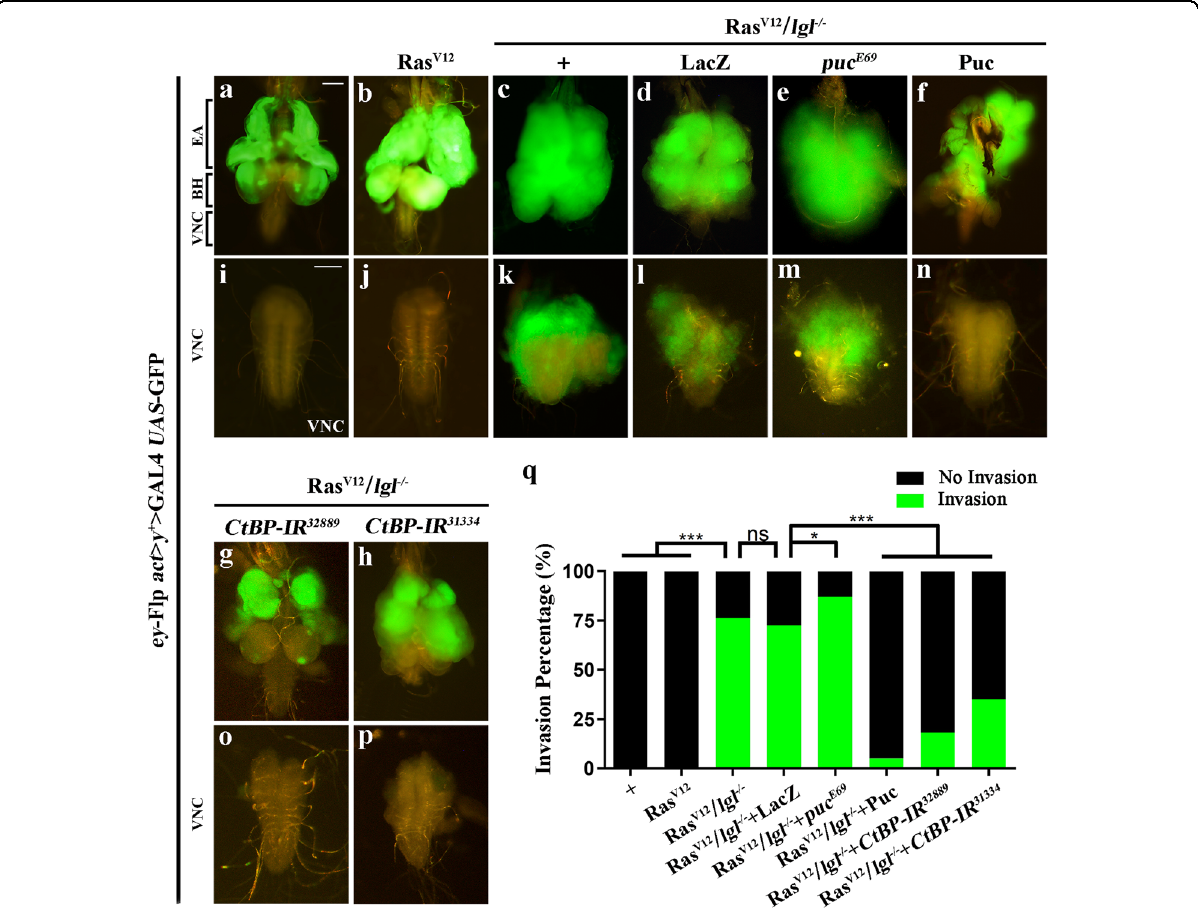
Fig. 1 CtBP is necessary for Ras V12 / lgl -/- -induced tumor growth and invasion. Fluorescent images showing Drosophila larval cephalic complexes (CC, a – h ) and ventral nerve cords (VNC, i -p), the anterior is to the up in all panels. The CC ( a ) contains eye – antennal disks (EA), brain hemispheres (BH), and VNC ( h ). GFP-labeled mosaic clones were created in the EA. Compared with the control ( a , h ), Ras V12 / lgl -/- induced tumor overgrowth ( c ) and invasion to the VNC ( j ) were enhanced by puc E69 heterozygosity ( e , m ), and strongly suppressed by expressing Puc ( f , n ), or depleting CtBP ( g , o , h and p ), but not expressing LacZ ( d , l ). Ras V12 -overexpressing clones showed a visible growth advantage ( b ), but did not migrate to the VNC ( j ). Statistical analysis of the invasion percentage ( q ) as shown in fi gures a – h ( a , 0.00%, n = 52; b , 0.00%, n = 55; c , 76.27%, n = 118; d , 72.58%, n = 124; e , 86.96%, n = 92; f , 5.09%, n = 118; g , 18.33%, n = 120; h , 35.19%, n = 108), respectively. Chi-squared test was applied to compute P -values, * P < 0.05, *** P < 0.001; ns, no signi fi cant difference. See the electronic supplementary material for detailed genotypes. Scale bar: 100 µm ( a – p